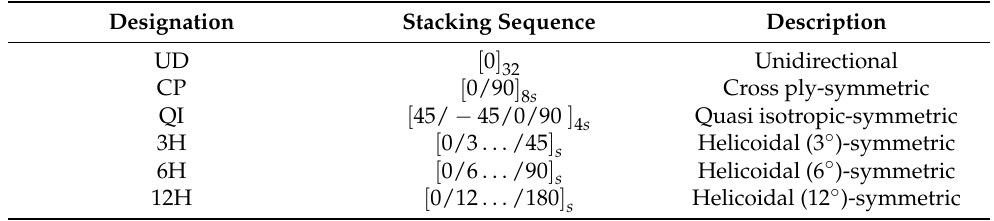
Table 1. Specifications of the chosen layup